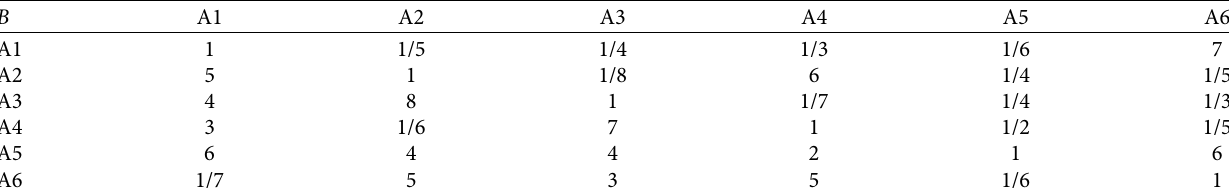
Table 3: The fuzzy judgment matrix.